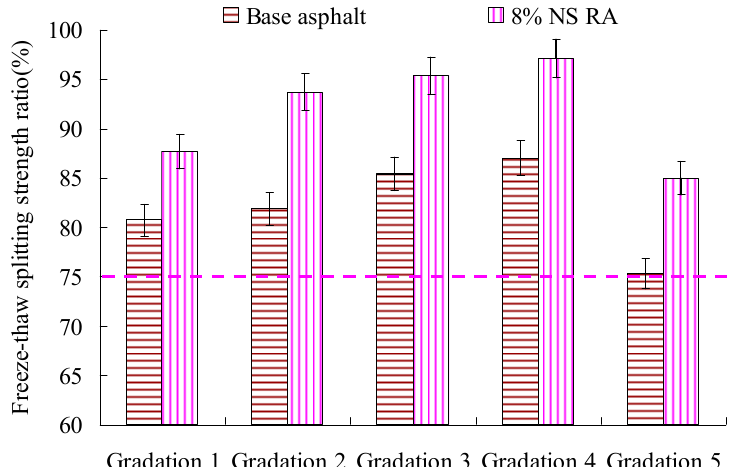
Figure 12. The freeze–thaw split test results of NS RA-modified asphalt mixtures with different gradations.